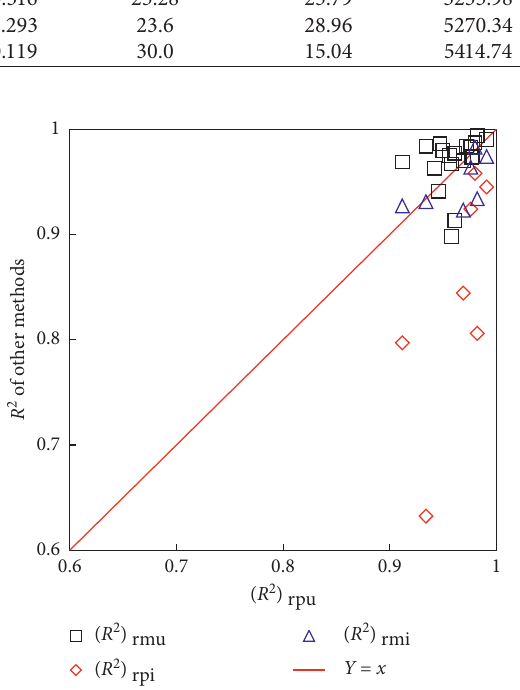
Figure 3: Regression squared correlation coefficient of equation (1) in two stress